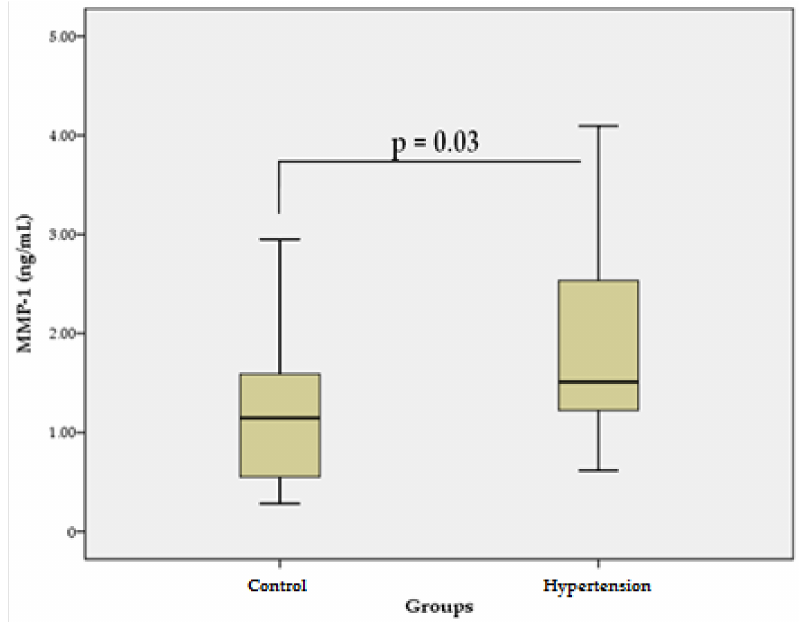
Figure 1. Serum levels of MMP-1 in the hypertensive group vs. control group. Data are represented as mean ±